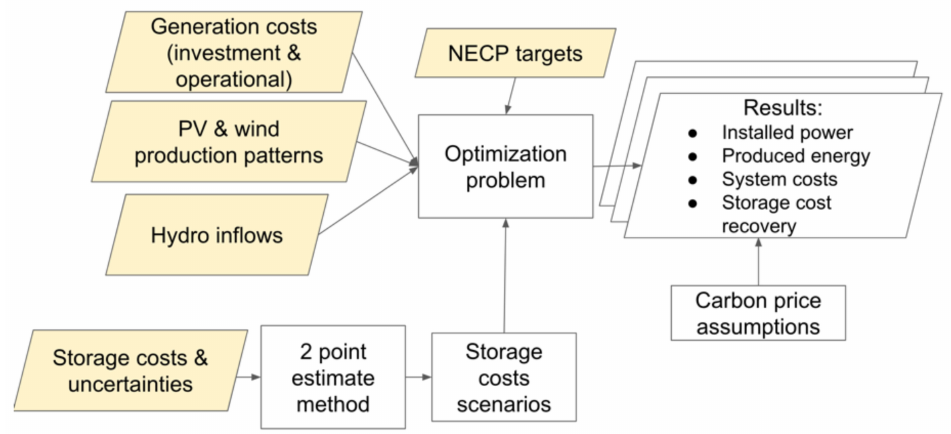
Figure 1. Outline of the followed method.